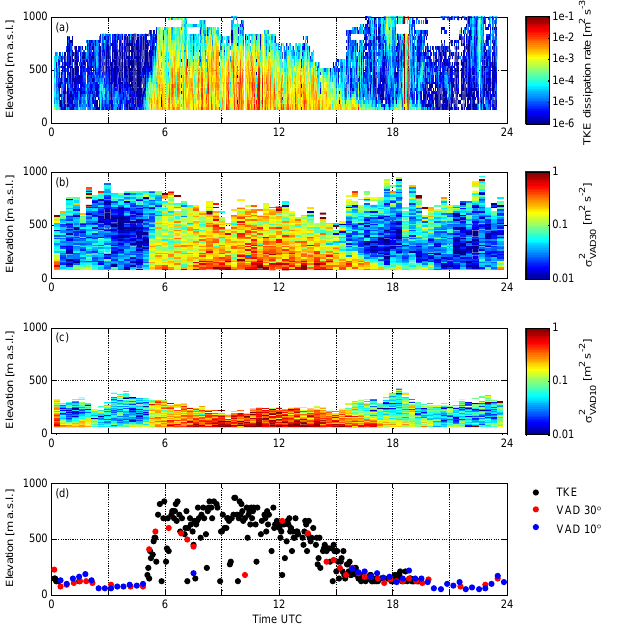
Figure 6. Diurnal variation at Loviisa on 26 December 2013 of (a) TKE dissipation rate, (b) σ 2 from 15 ◦ elevation angle VAD, (c) VAD σ 2 from 4 ◦ elevation angle VAD and (d) MLH. VAD